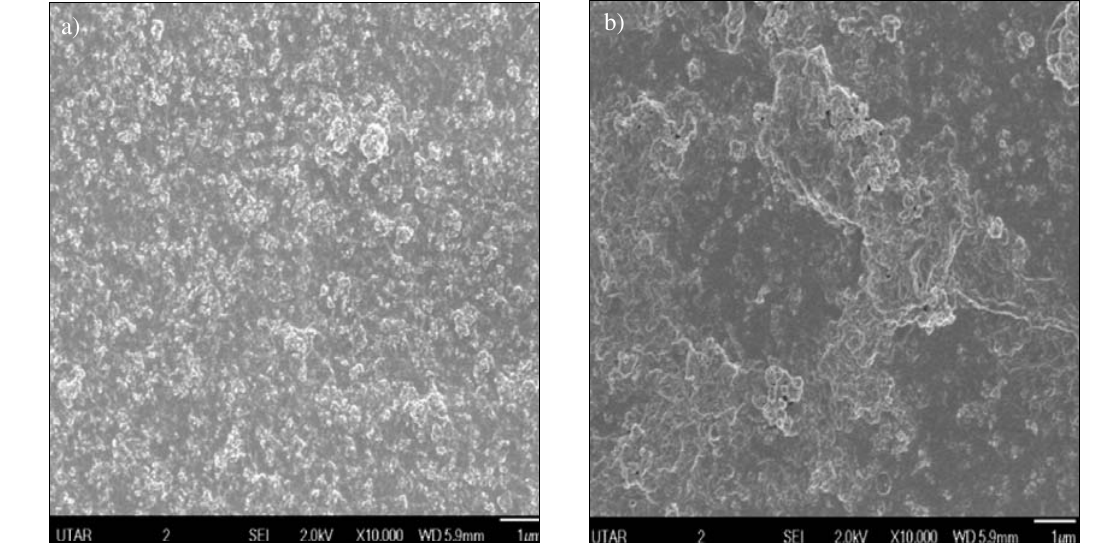
Figure 2. SEM micrographs of TiO